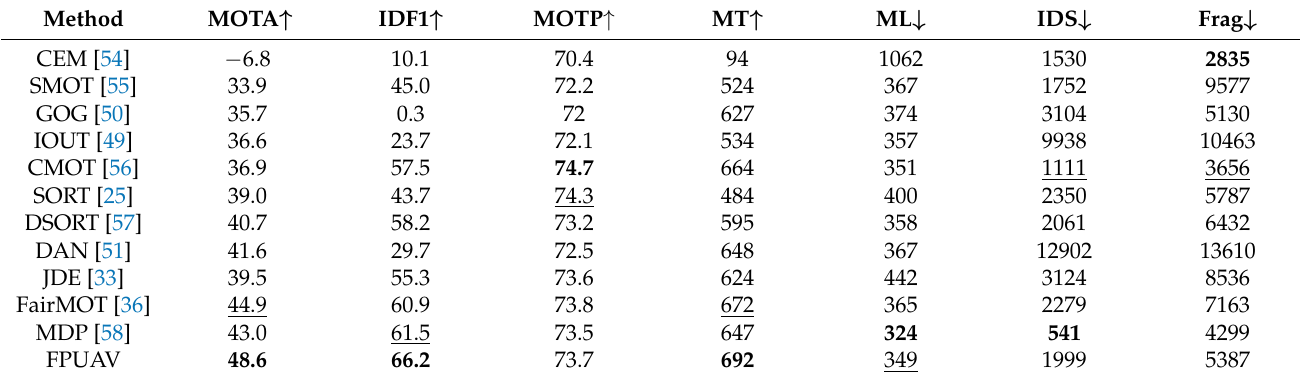
Table 2. Comparison with state-of-the-art methods on